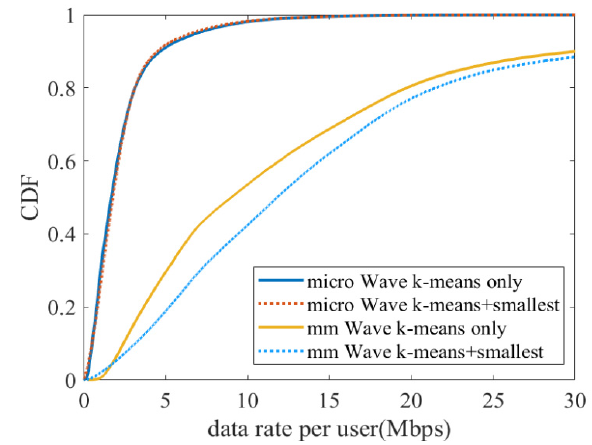
Figure 11. Methods’ comparison with microwaves.